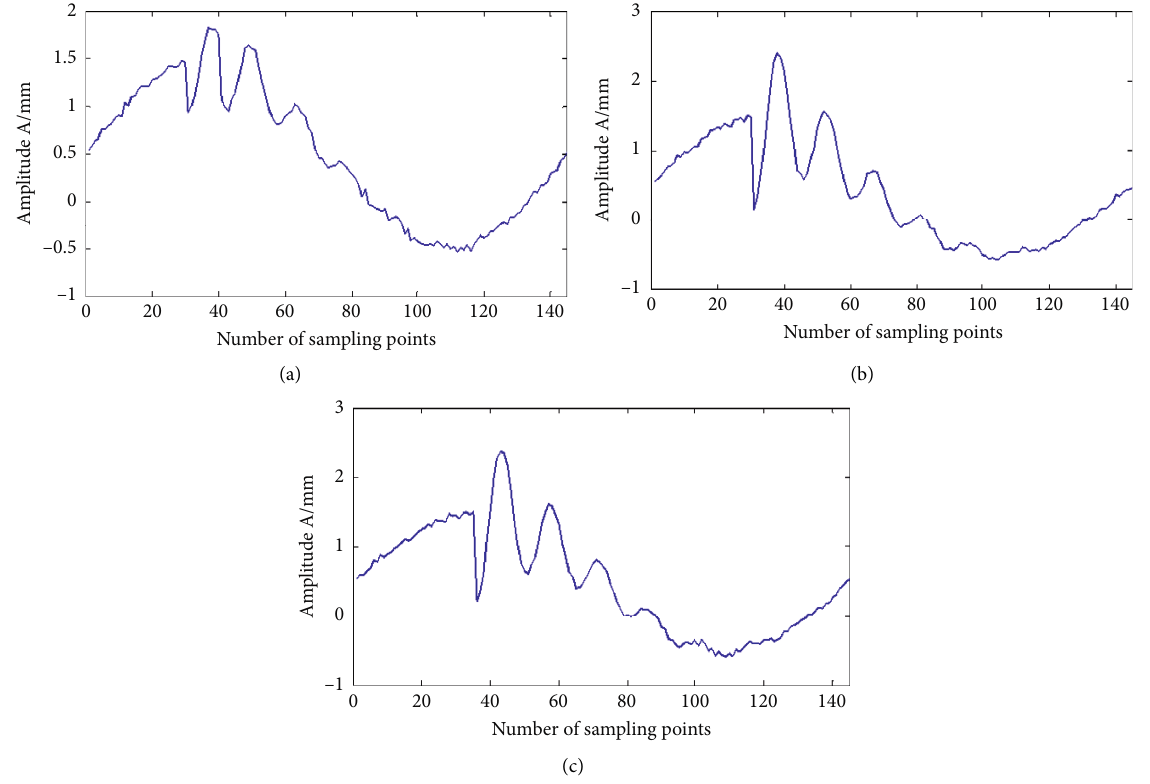
Figure 5: Comparison of treatment results of different methods. (a) Traditional processing results, (b) improved treatment results, and (c) ideal synchronization